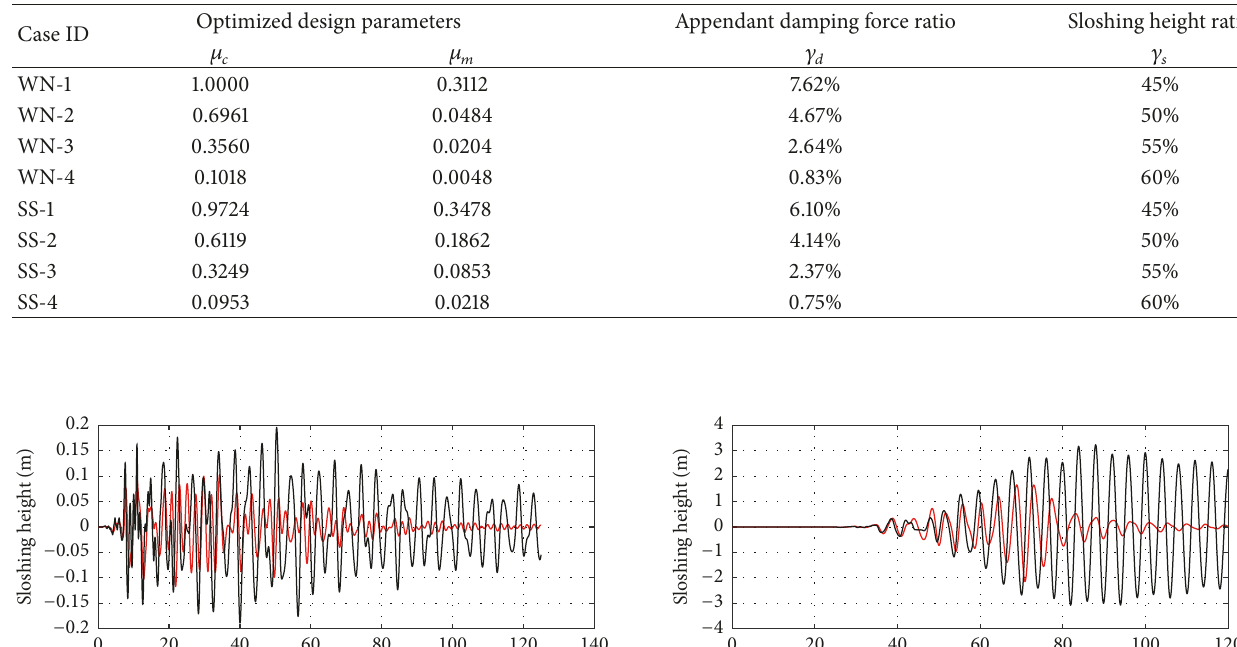
Table 2: Optimization results for the parameters of the hybrid-controlled tank.